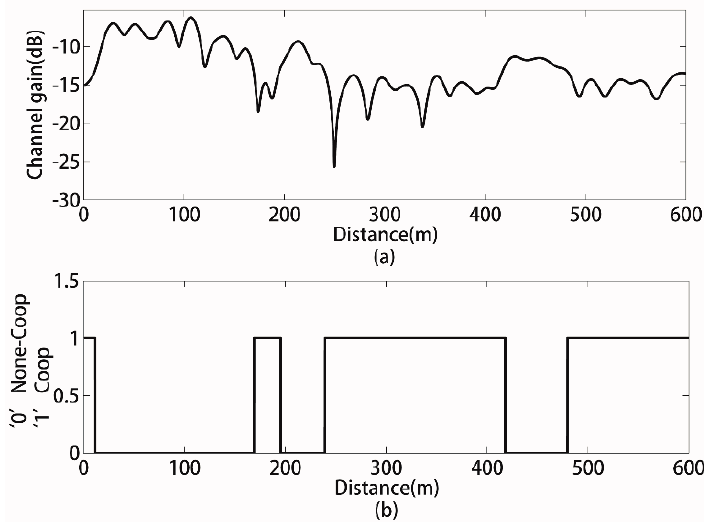
Figure 5. The average channel gain changes with the distance to the sink node in